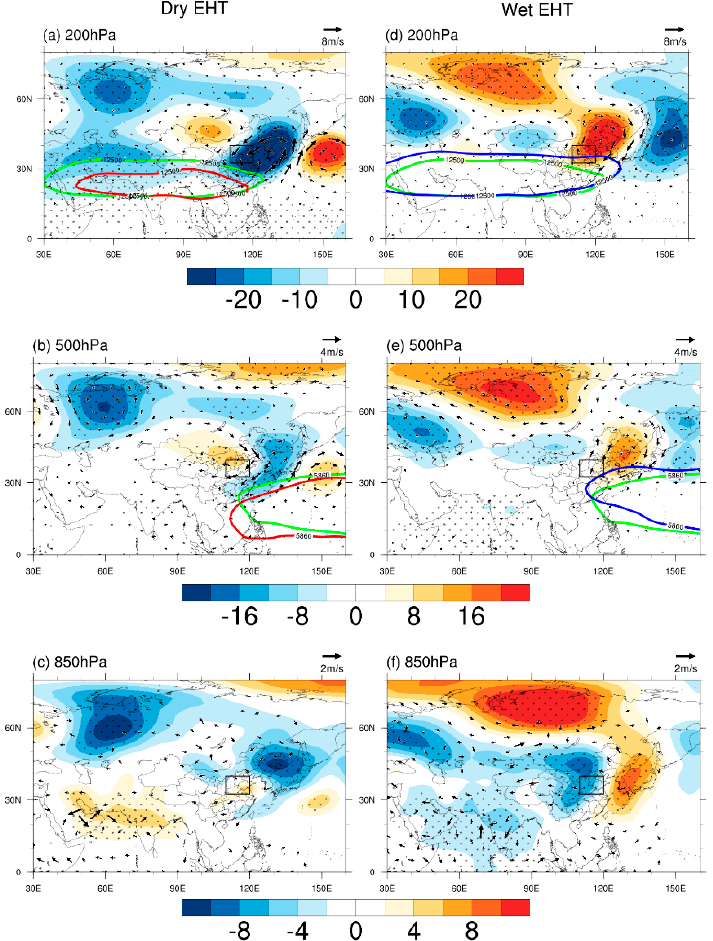
Figure 5. Composite anomalies of GPH (shadings; unit: gpm; dotted areas are significant at the 99% confidence level) and wind (vector; unit: m/s) for dry and wet EHT days in MLRYR. ( a – c ): dry EHT, ( d – f ): wet EHT. The solid green lines are the climatological-mean bodies of SAH at 200 hPa and WPSH at 500 hPa, and the red (blue) lines at 200 hPa and 500 hPa are SAH and WPSH bodies for the dry (wet) EHT days.